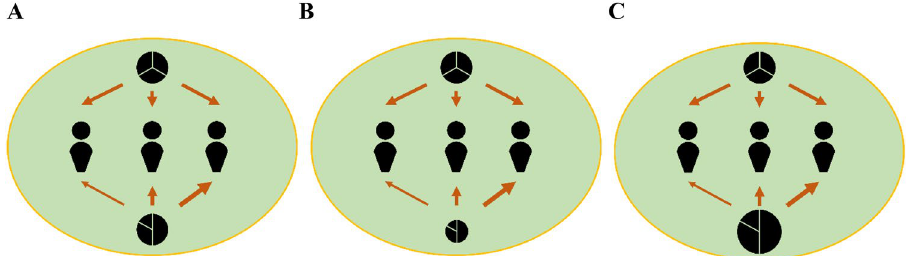
Figure 1. Unequal returns in a multiple-public goods game. Three individuals can contribute out of a personal endowment to two public goods depicted as black circles, that vary in their efficiency, depicted by the circles’ surfaces ( B, C ) and that provide (un)equal returns to group members, depicted as the part of the circle and the thickness of the arrows ( A ), where the equal-returns public good is more efficient than the unequal-returns public good (no decision conflict), ( B ) or where the equal-returns public good is less efficient than the unequal returns public good (decision conflict) ( C